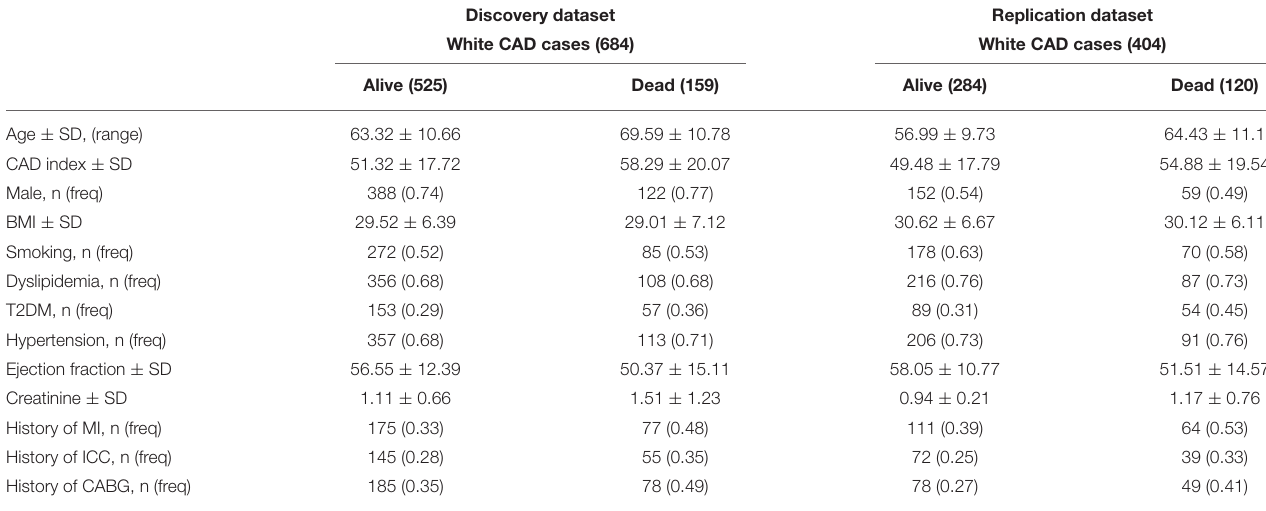
TABLE 1 | Participant